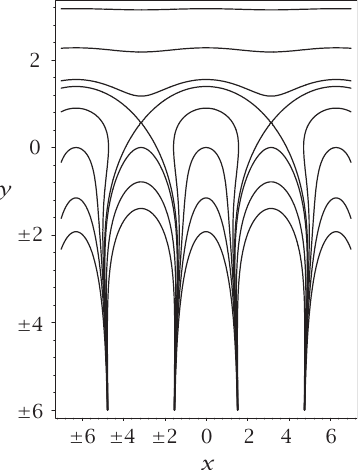
Figure 3.1 . Streamline pattern for − y 2 + 2 e − y cos x =